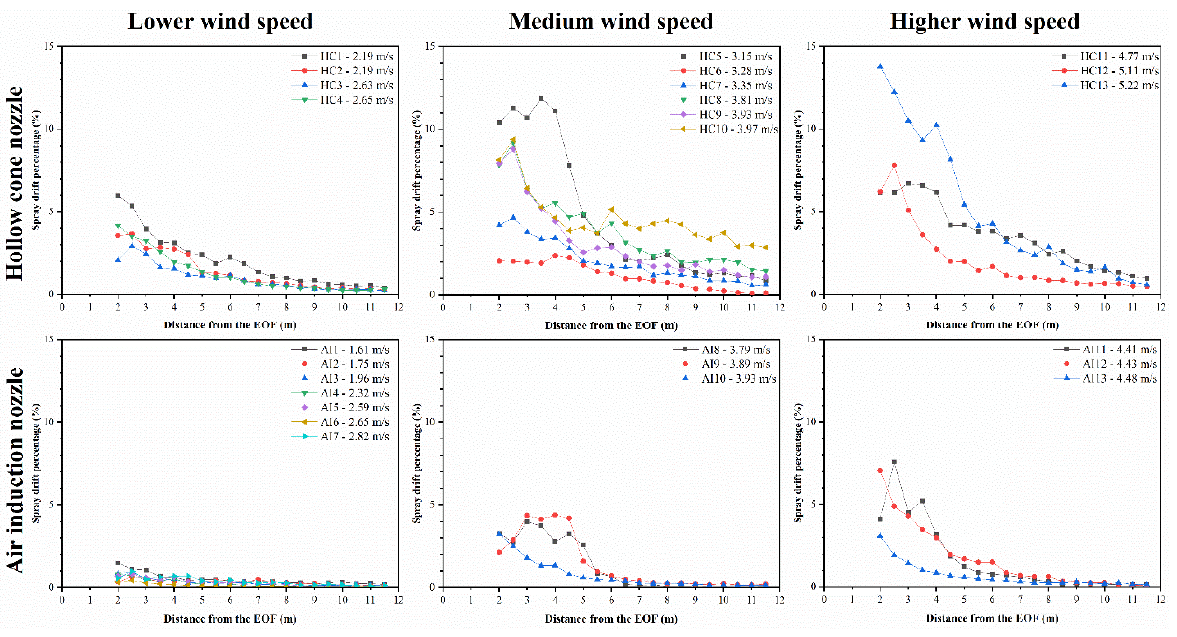
Figure 5. Spray drift percentage profiles obtained from the test bench using UASS with HC and AI nozzles at lower wind speed (LWS, <3.0 m s − 1 ), medium wind speed (MWS, 3.0 ≤ 4.0 m s − 1 ), and higher wind speed (HWS, ≥ 4.0 m s − 1 ).